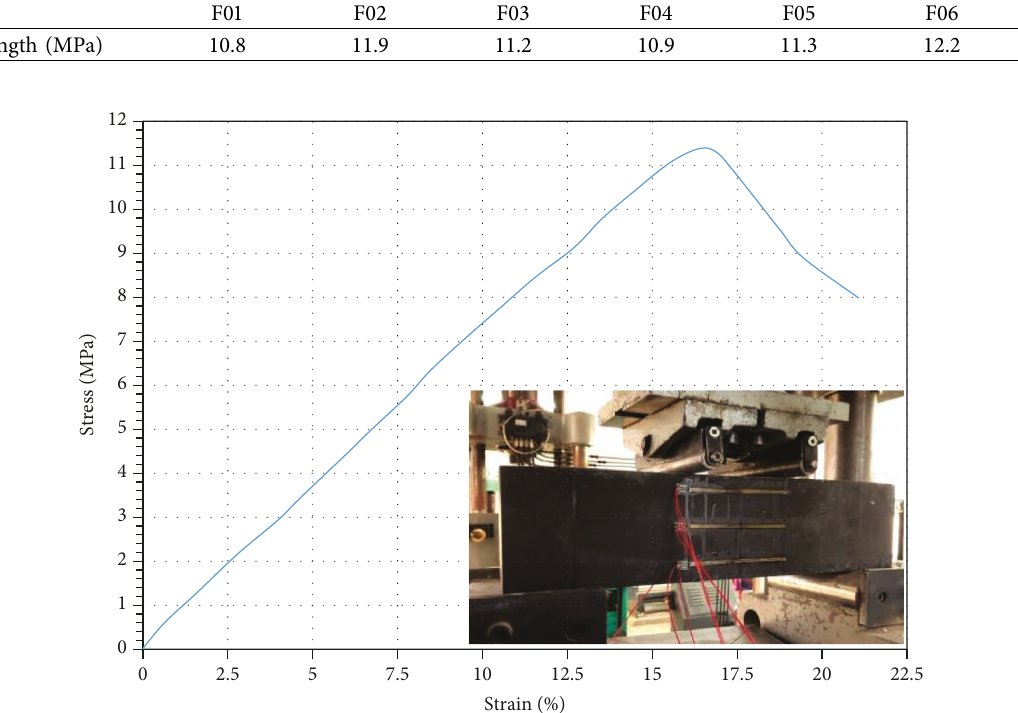
Figure 22: The flexural strength stress-strain curve of polyurethane